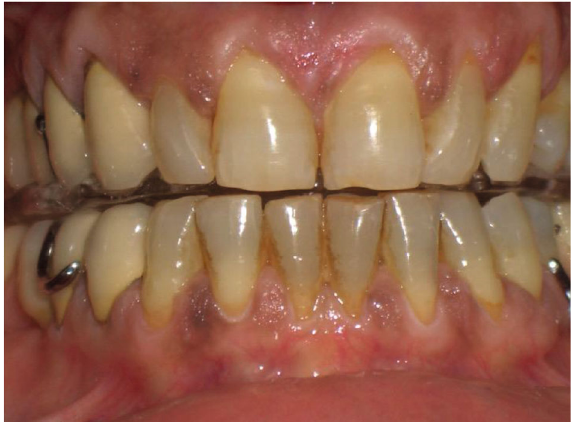
Figure 4: Reposition appliance DITRA.